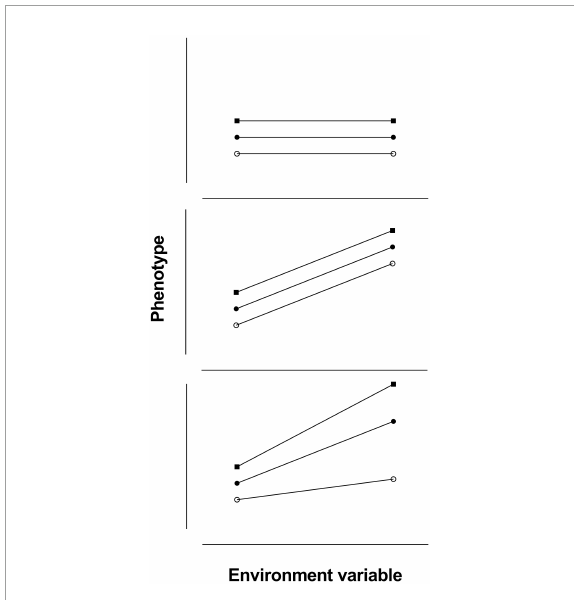
FIGURE5 Reaction norms for individual animals with no phenotypic plasticity (reaction norms parallel with slopes equal to zero; upper panel), the same degree of phenotypic plasticity (reaction norms parallel with slopes not equal to zero; middle panel), and individual variation in plasticity (reaction norms not parallel with slopes not equal to zero; lower panel).